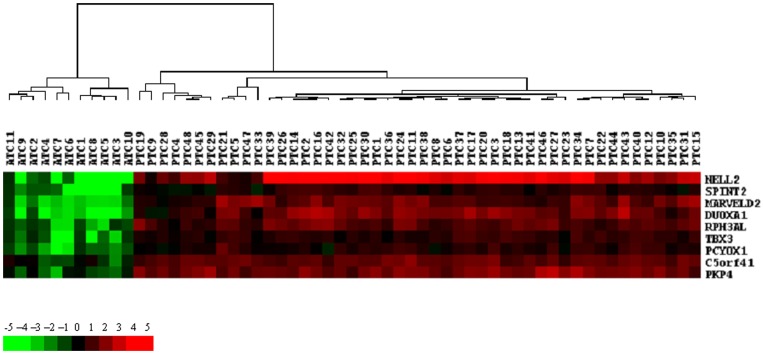
Hierarchical clustering and heat map with the 9 genes composing the signature discriminating ATC and PTC samples.